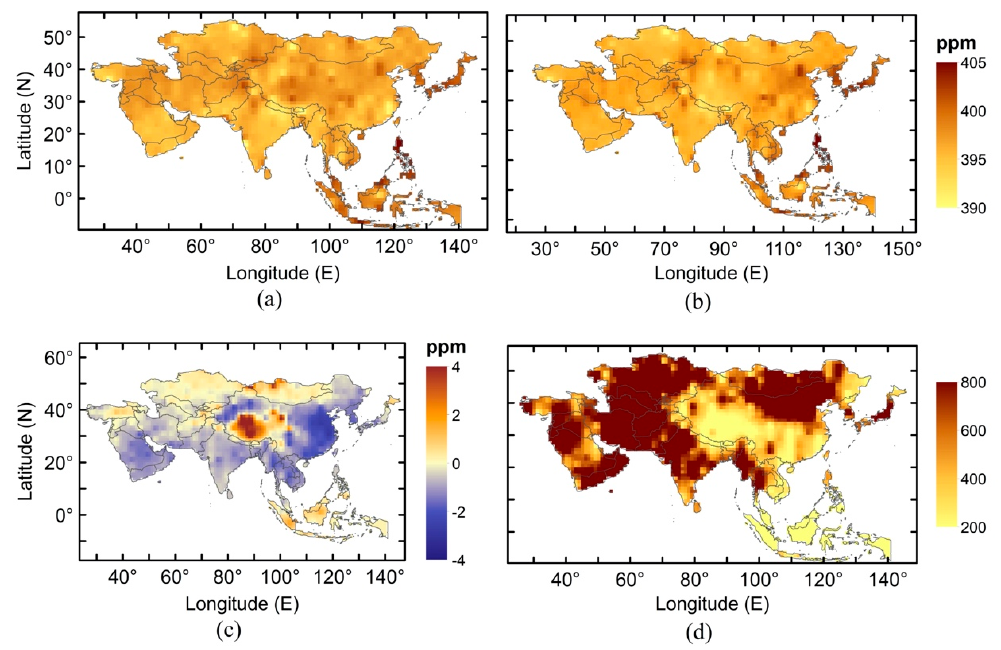
Figure 2. ( a ) Distribution of 10 years mean XCO 2 over Asia for ( a ) CarbonTracker (CT) 2019; ( b ) Greenhouse Gases Observing Satellite (GOSAT); ( c ) their di ff erences (CT-GOSAT); and ( d ) the total number of datasets from GOSAT in each grid.